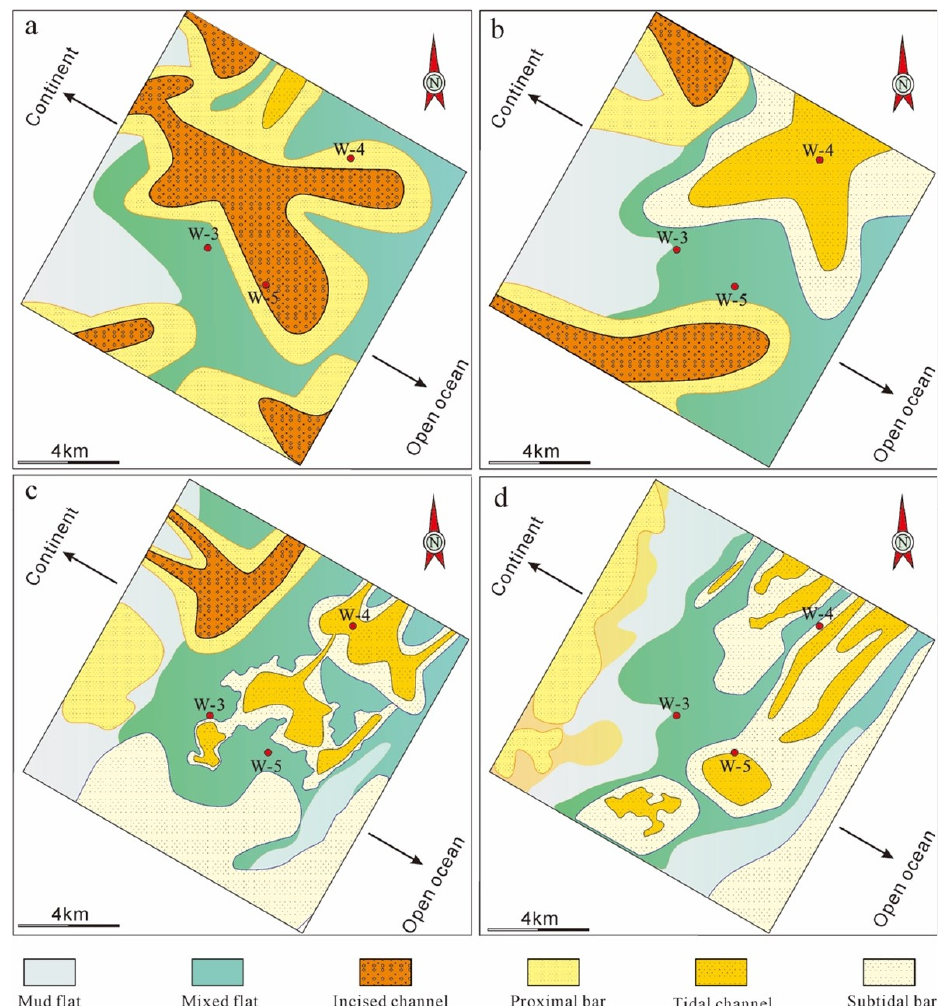
Figure 13. Horizontal distribution of sedimentary facies’ profile of well W-4, W-2, W-5, W-3, and W-1 of the Pinghu Formation.